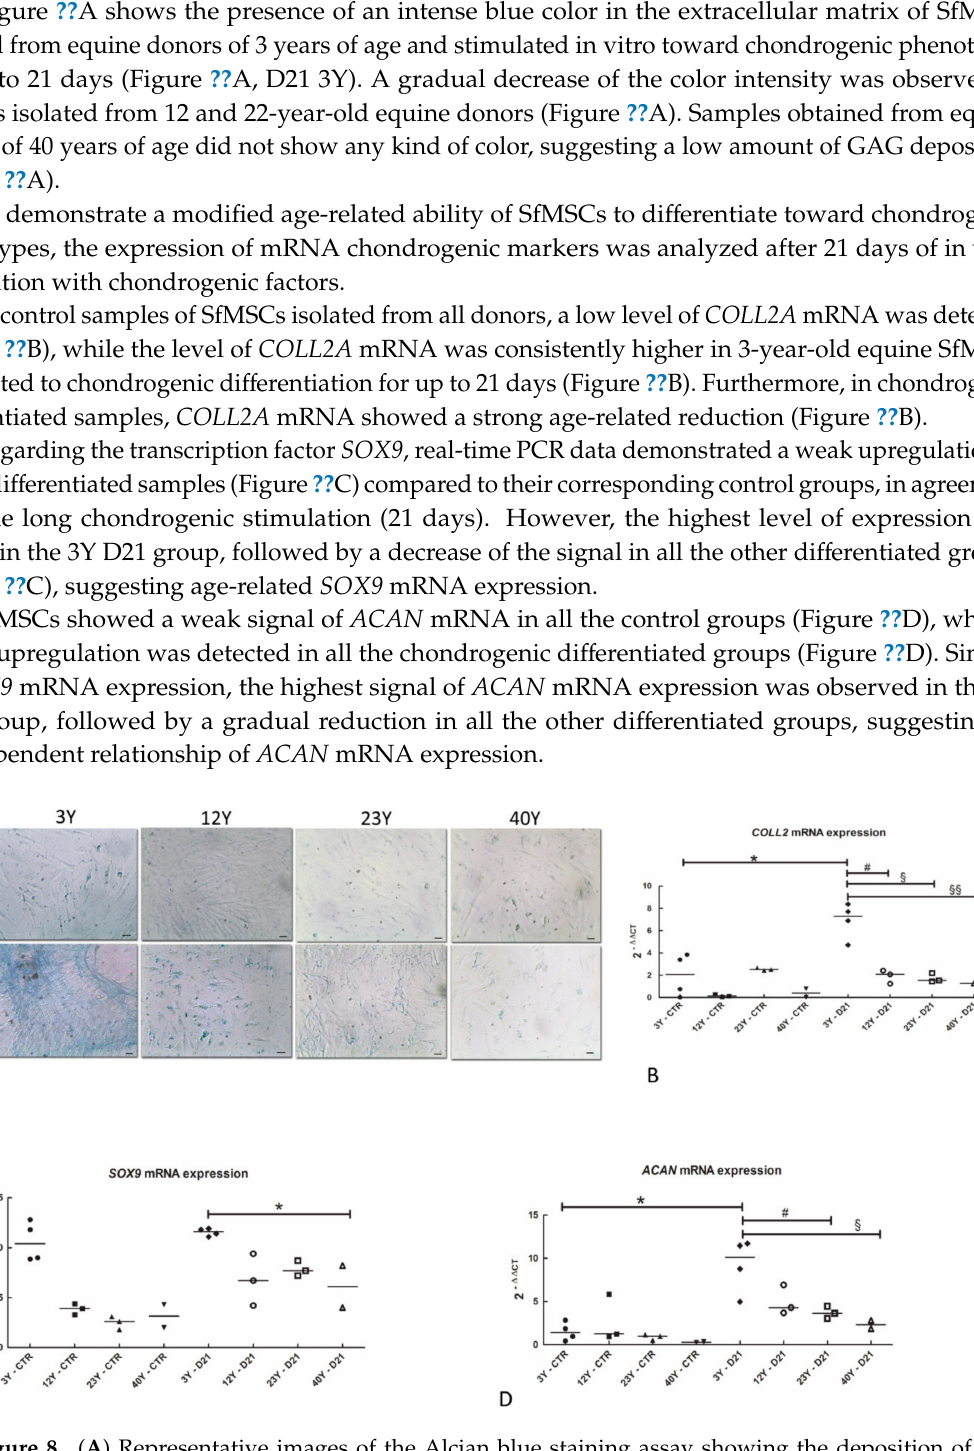
Figure 8. ( A ) Representative images of the Alcian blue staining assay showing the deposition of glycosaminoglycans (GAG) in the extracellular matrix in SfMSCs, isolated from equine donors of 3-year-olds (3Y), 12-year-olds (12Y), 23-year-olds (23Y), and 40-year-olds (40Y) and stimulated toward chondrogenic phenotypes for up to 21 days (scale bar: 30 µ m). ( B ) Real-time PCR relative expression of COLL2 mRNA in control (CTR) and di ff erentiated (D21) SfMSCs toward chondrogenic phenotypes